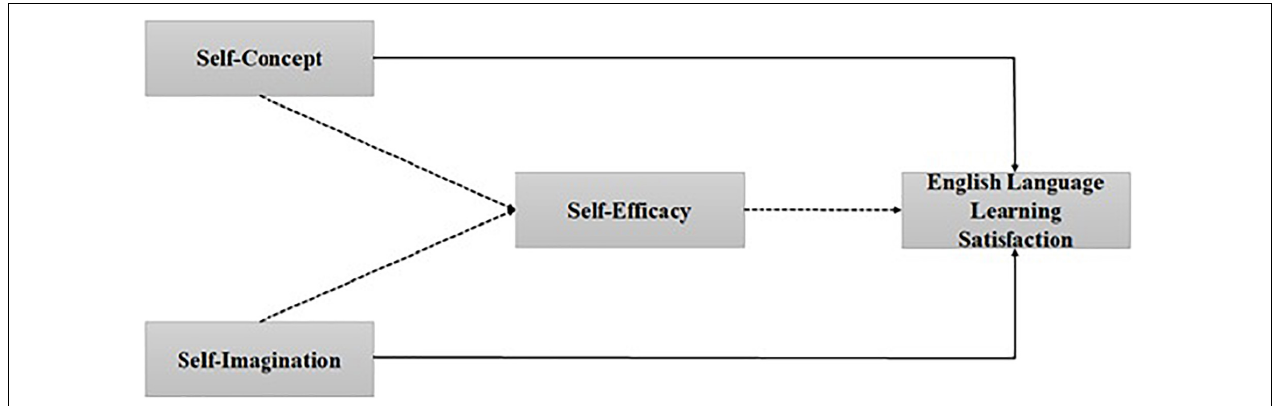
FIGURE 1 | Research